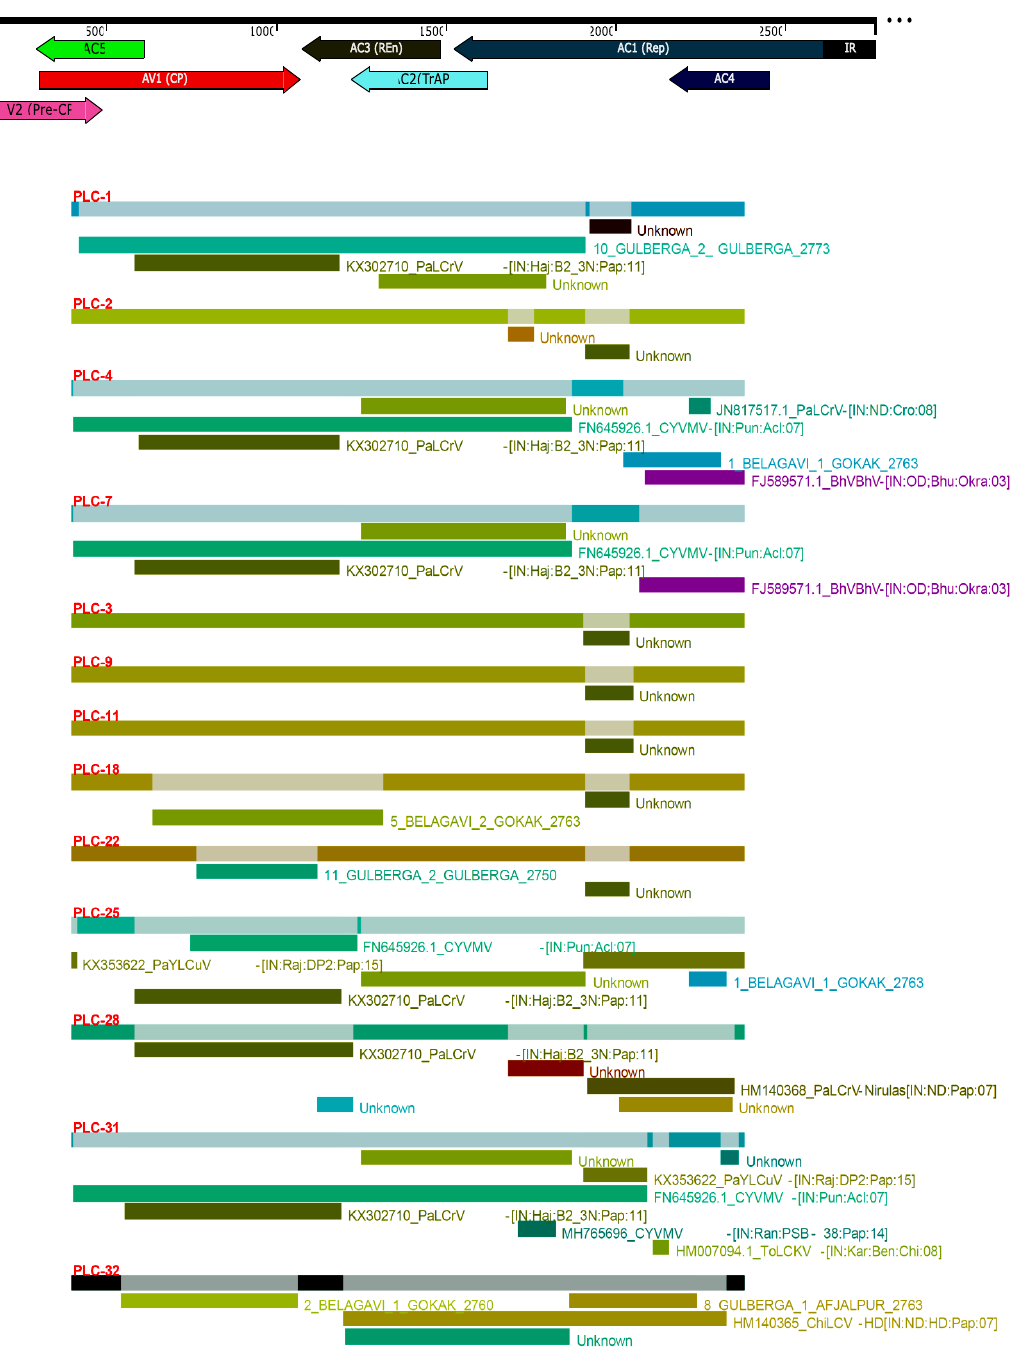
Figure 6. Recombination analysis of breakpoints and its putative parental sequences of isolated begomoviruses from papaya.